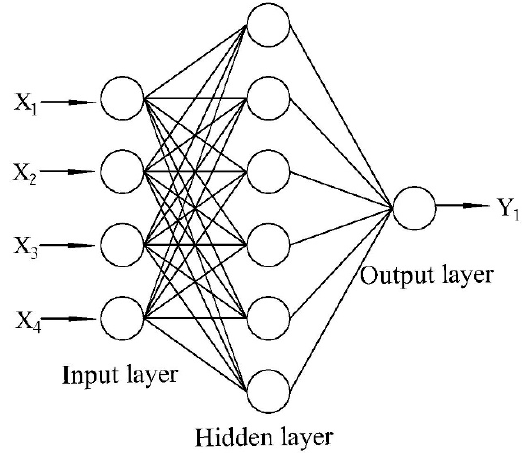
Figure 4. BP (Back Propagation) neural network structure diagram (X 1 : drying time; X 2 : measuring point position; X 3 : temperature; X 4 : pressure; Y 1 : MC (moisture content)).